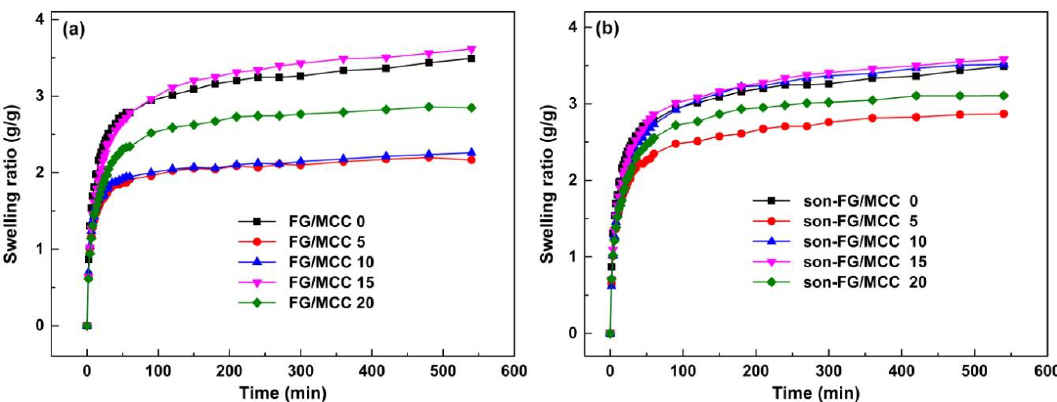
Figure 5. The swelling ratios of the films ( a ) and the ultrasonic films ( b ) immersed in distilled water with different time. Table 3. The equilibrium swelling ratios (S eq , g/g ) of the FG/MCC films with different MCC content. Samples